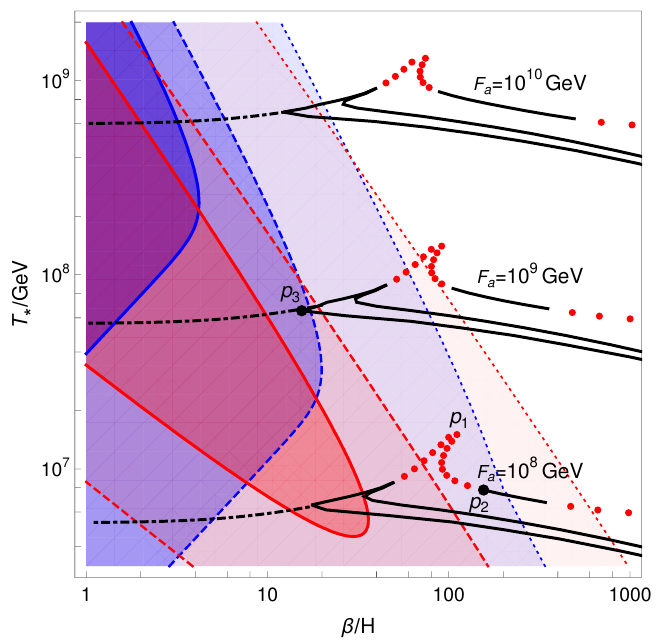
Figure 5 . Predicted values of T (cid:3) and (cid:12)=H (cid:3) for the DSFZ axion model (3.7) for F a = 10 8 , 10 9 and 10 10 GeV (see section 3.2.1 for more details). The present and expected future experimental GW reaches are depicted as red and blue areas, using the same color code as in (cid:12)gure